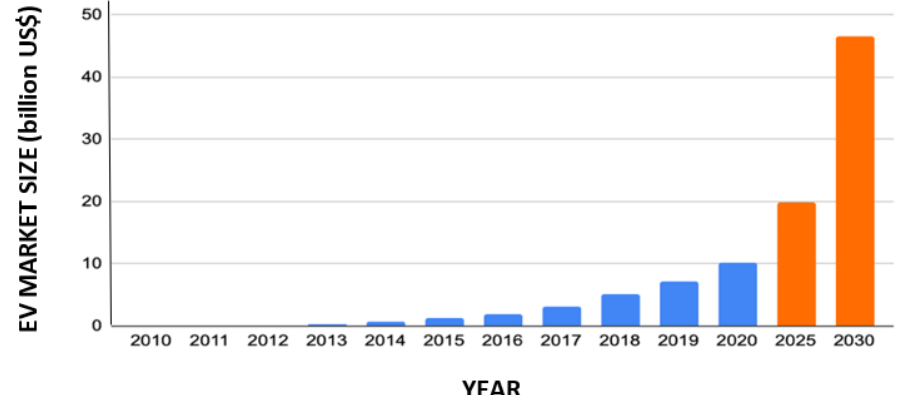
Figure 5. EV market size (in billion USD) from 2010–2020 and projected market size till 2030.